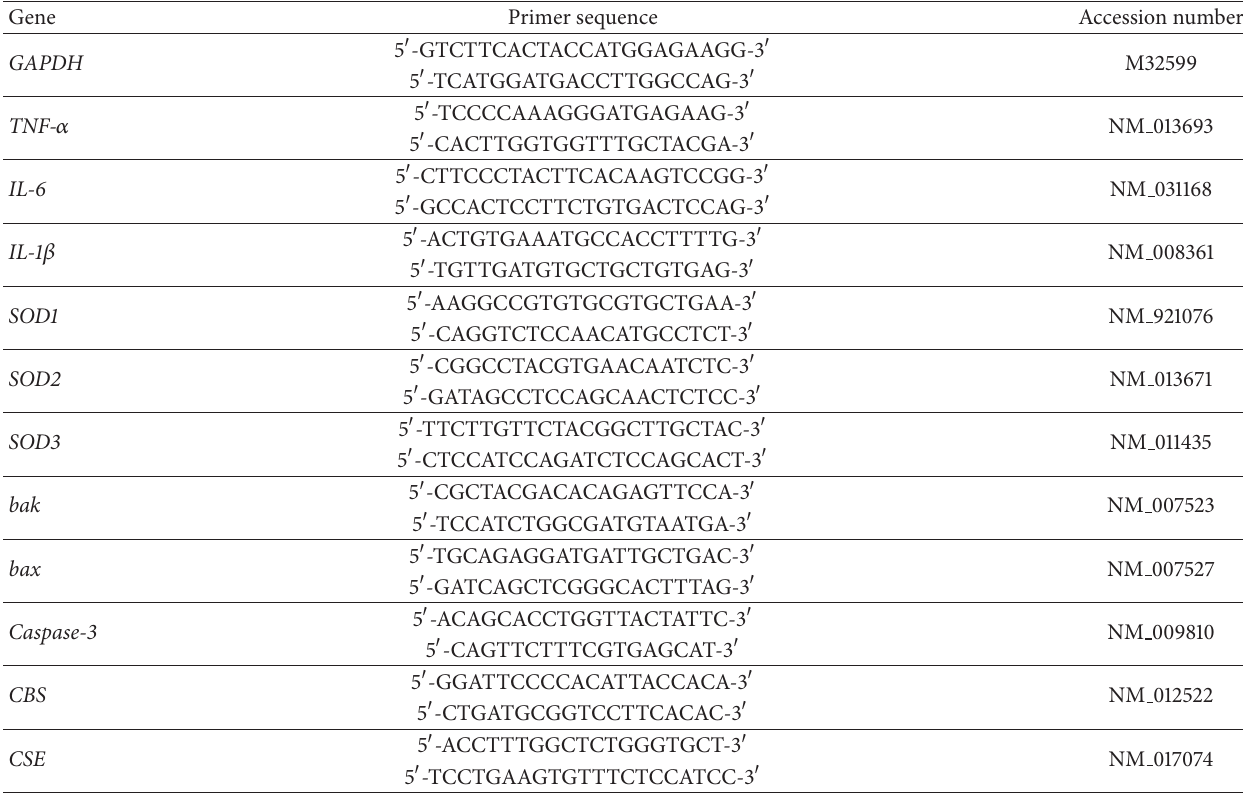
Table 1: Sequences of qRT-PCR